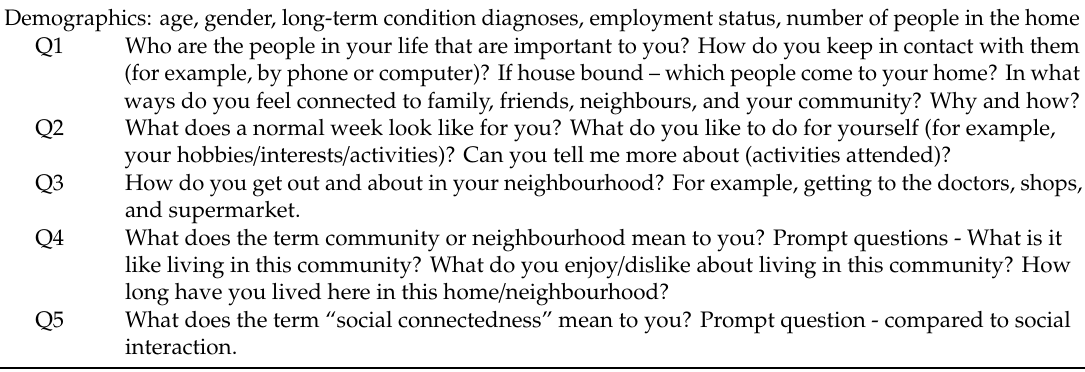
Table 1. Semi-structured interview